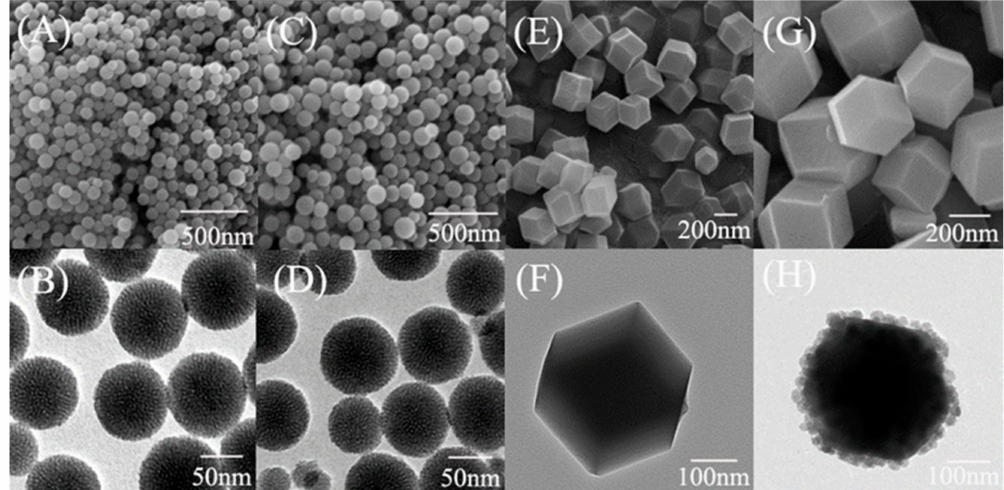
Figure 2. Scanning electron microscope (SEM) and Transmission electron microscopy (TEM) images of different materials. ( A ) SEM of mesoporous silica nanoparticles (MSN), ( B ) TEM of MSN, ( C ) SEM of carboxyl modified silica nanoparticles (MSN-COOH) ( D ) TEM of MSN-COOH, ( E ) SEM of zeolitic imidazolate framework-8 (ZIF-8) ( F ) TEM of ZIF-8, ( G ) SEM of core–shell nanocomposite prepared by ZIF-8 immobilized ADH, LDH and MSN-NAD (ZIF@ADH/NAD-MSN/LDH), ( H ) TEM of